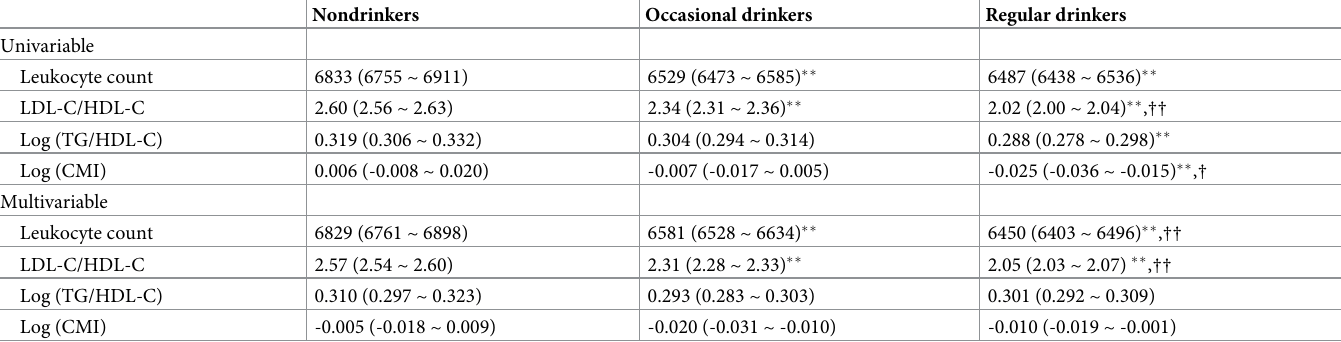
Table 3. Comparison of mean levels of leukocyte count and lipid-related indices in non-, occasional and regular drinkers in overall